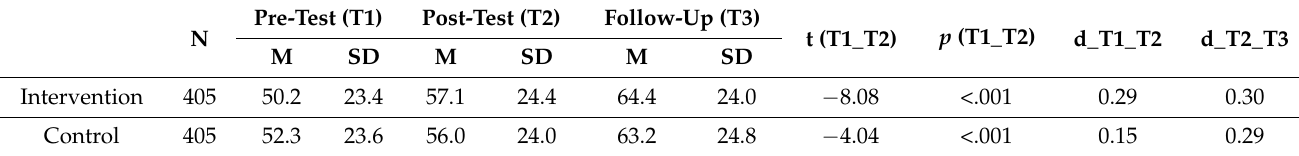
Table 3. Within group differences on the pre-test, post-test and follow-up